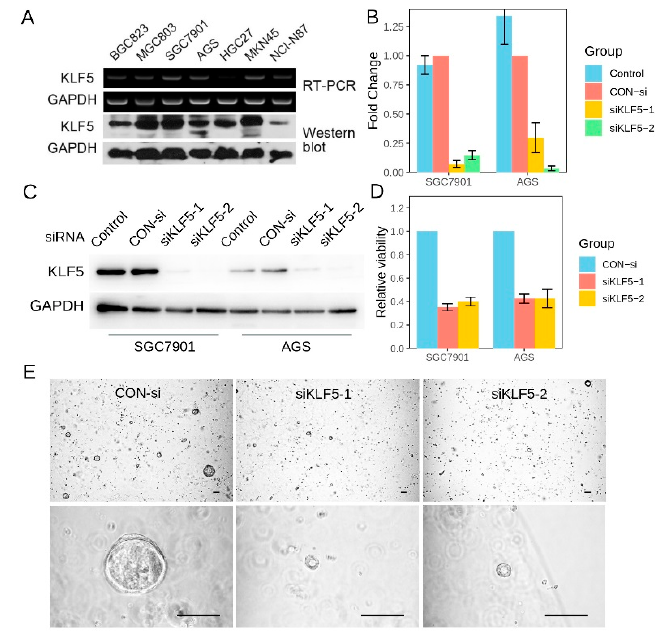
Figure 8. KLF5 was essential for the proliferation of gastric cancer cells. ( A ) KLF5 mRNA (RT-PCR) and protein (Western blot) expression in seven gastric cancer cell lines; ( B ) RT-PCR showing that KLF5 specific siRNA could downregulate KLF5 mRNA effectively in two gastric cancer cell lines; ( C ) Western blot confirmation of KLF5 downregulation in gastric cancer cell lines; ( D ) MTT assay showing that cell proliferation was significantly compromised after KLF5 was downregulated by siRNA; ( E ) the proliferation of gastric organoids was significantly reduced when KLF5 was down- regulated by siRNA, as indicated by lower organoid formation efficiency and smaller organoid size. Abbreviations: RT-PCR, real-time PCR; CON-si, control siRNA. The scale bar indicated 100 μ m.